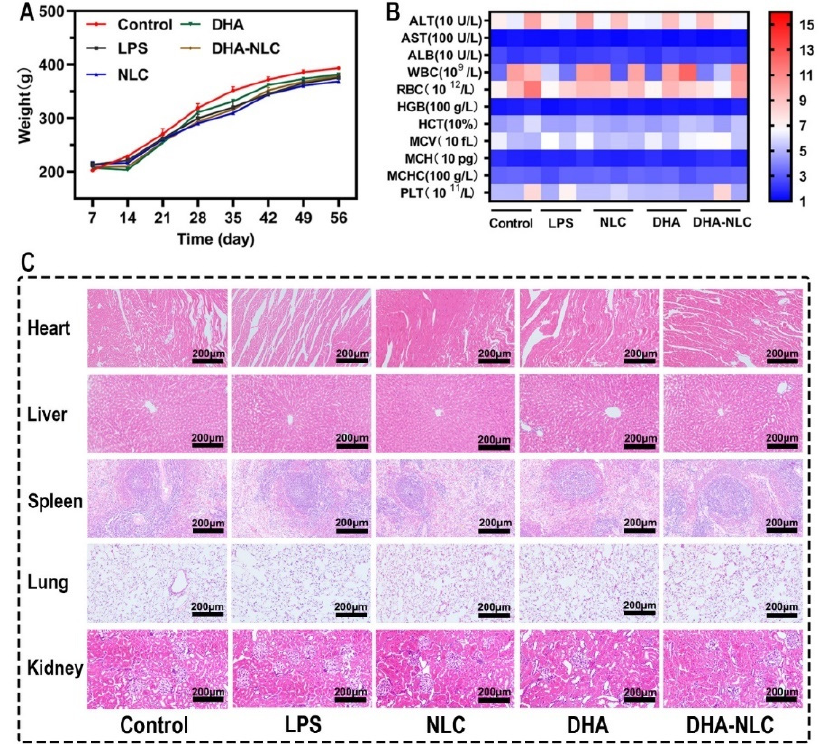
Figure 6. Biosafety of each group in vivo. ( A ) Effect of each group on rat weight during the experimen- tal period. ( B ) Effect of each group on alanine aminotransferase (ALT), aspartate aminotransferase (AST), albumin (ALB), white blood cells (WBC), red blood cells (RBC), hemoglobin (HGB), hematocrit (HCT), mean corpuscular volume (MCV), mean corpuscular hemoglobin (MCH), mean corpuscular hemoglobin concentration (MCHC), and platelet (PLT) levels. ( C ) H&E staining of the heart, liver, spleen, lung, and kidney tissues. Scale bars: 200 µ m. LPS, lipopolysaccharide. NLC, nanostructured lipid carrier. DHA, docosahexaenoic acid.